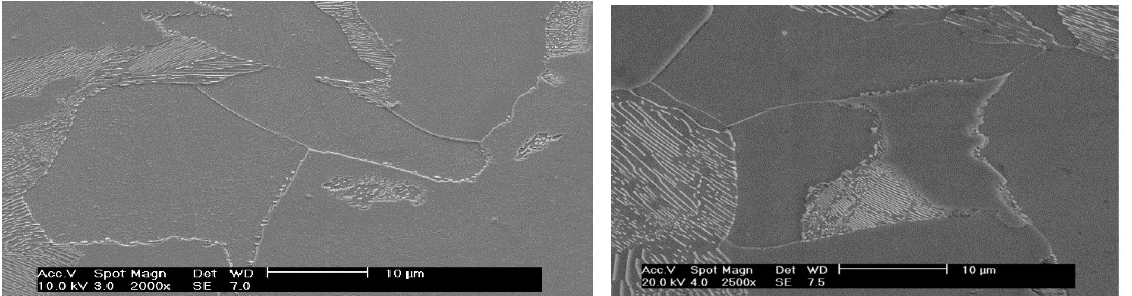
Fig. 6: Initial Sem Micrograhs of Steel-A and Stee-B having Nb and without Nb